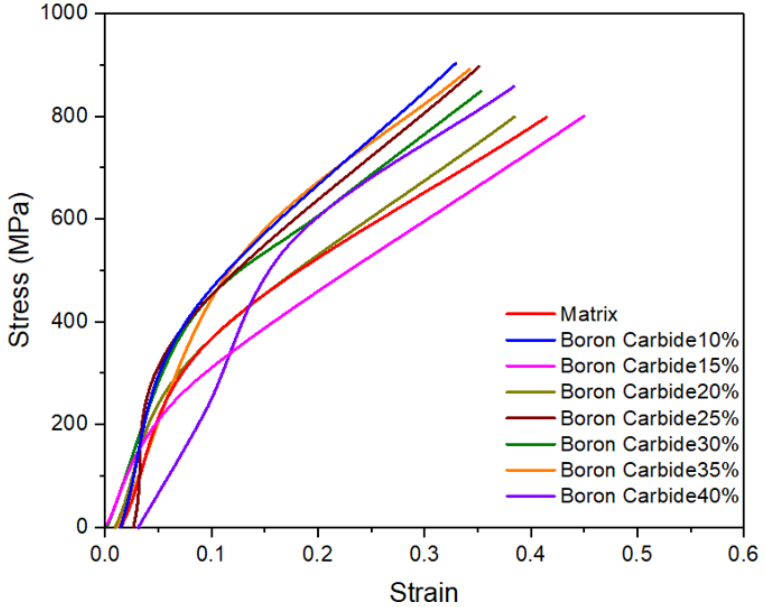
Figure 9. The matrix for compressive stress – strain and various coatings B 4 C /Ni63.